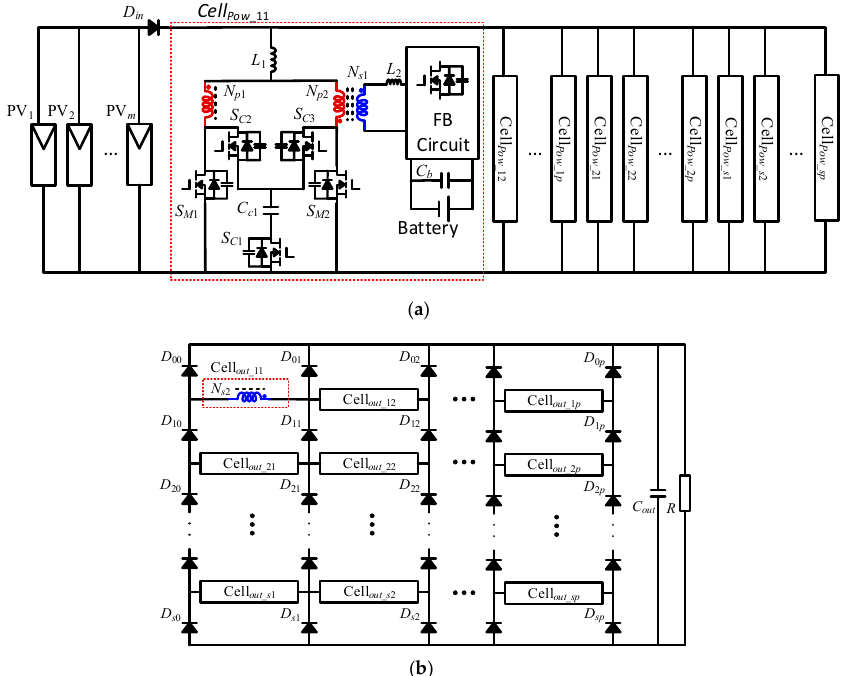
Figure 7. Topology of the proposed converter with s rows and p columns: ( a ) primary circuits with ES system; ( b ) secondary circuits connecting.